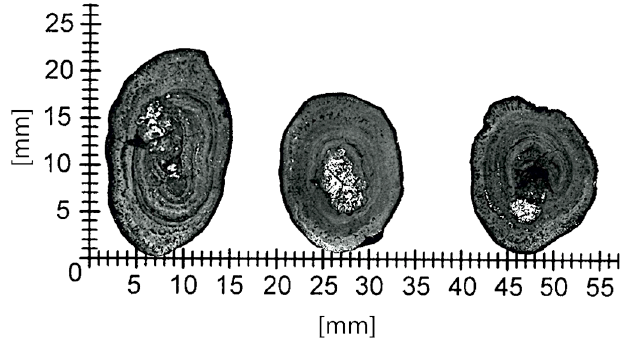
Figure 3. Example views of the chipping ( a ) and smooth ( b ) cross-sections of polymetallic concretions formed using a high-pressure AWJ.